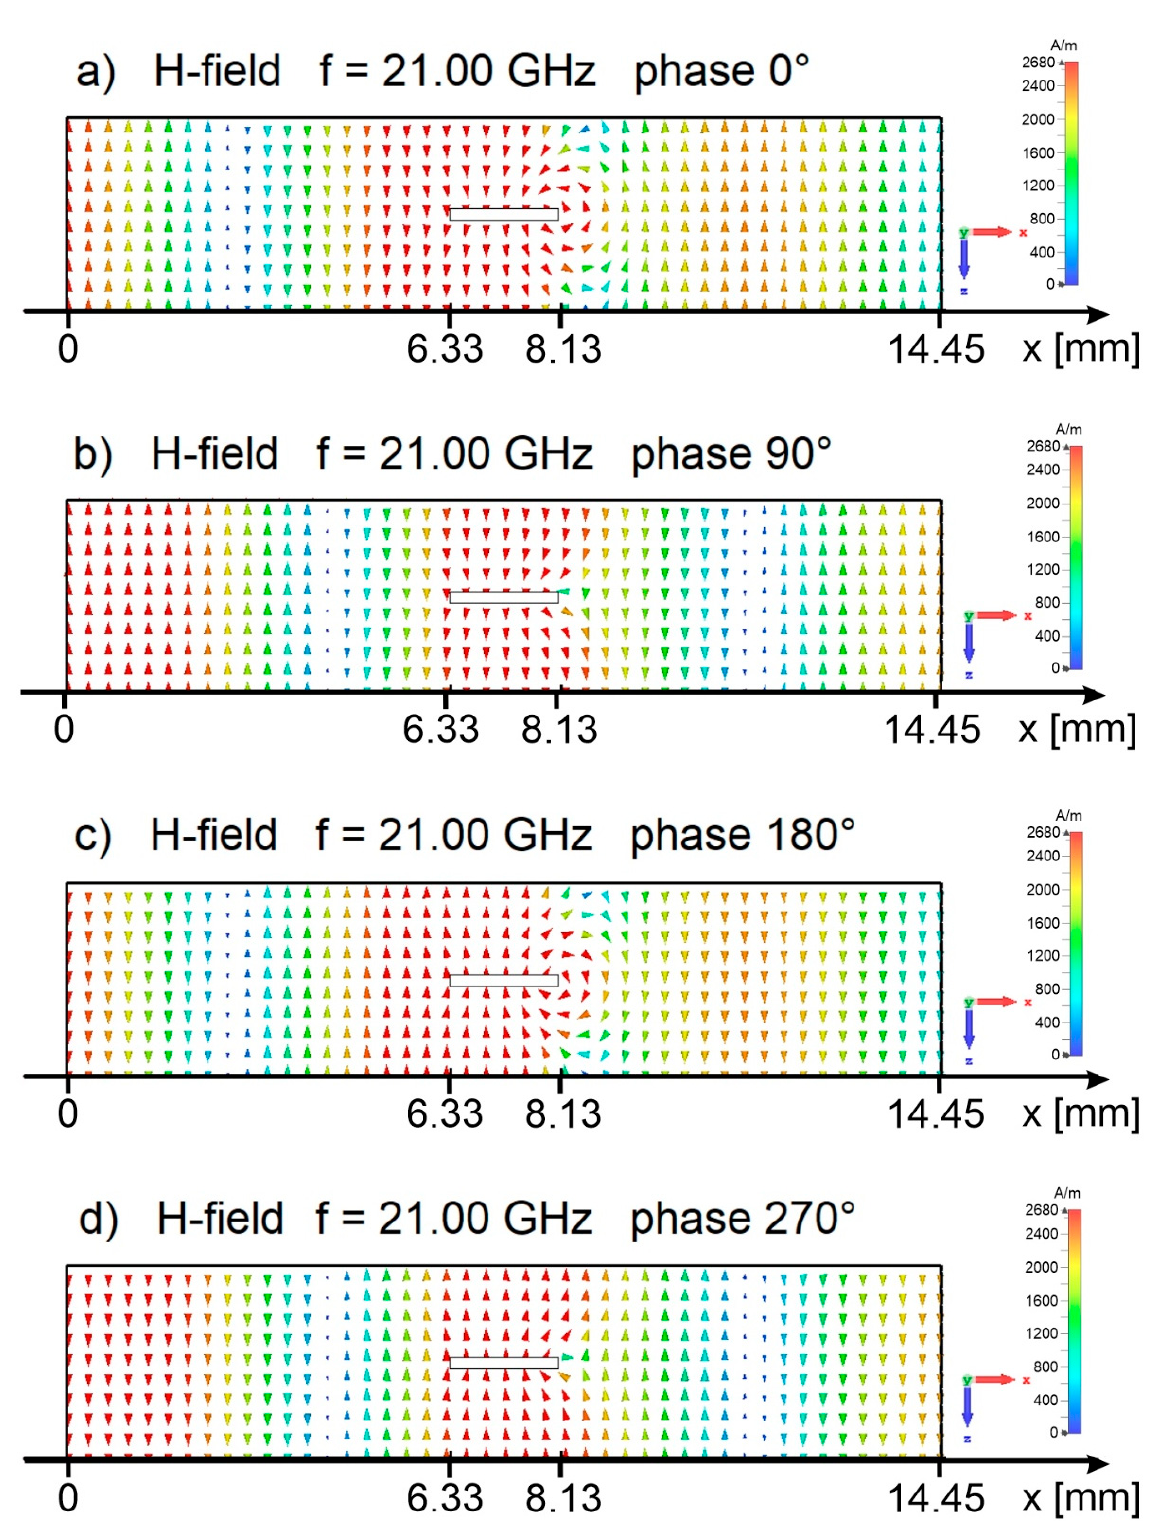
Figure 9. Distribution of the magnetic field H in the cross-sections xz for y = 1.9 mm at f = 21 GHz corresponding to the detune magnetic resonance. The plane electromagnetic wave propagates in the +x axis: ( a ) Phase 0°; ( b ) phase 90°; ( c ) phase 180°; ( d ) phase 270°. The wave incident on the SRR structure results in partial reflection (19%) and transmission (81%).